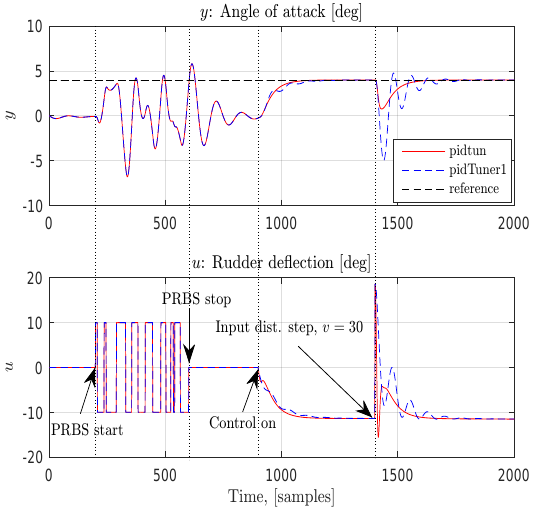
Figure 5: Example 4.2. The figure shows the open loop output and excited input data used for com- puting the PID controller ( m = 2) parame- ters (see Table 2) in pidtun (Algorithm 1) and pidTuner1 (Algorithm 2). It shows the reference, r = 4, and input disturbance step, v = 30, time domain responses of the closed loop system illustrated in Figure 4, compar- ing pidtun